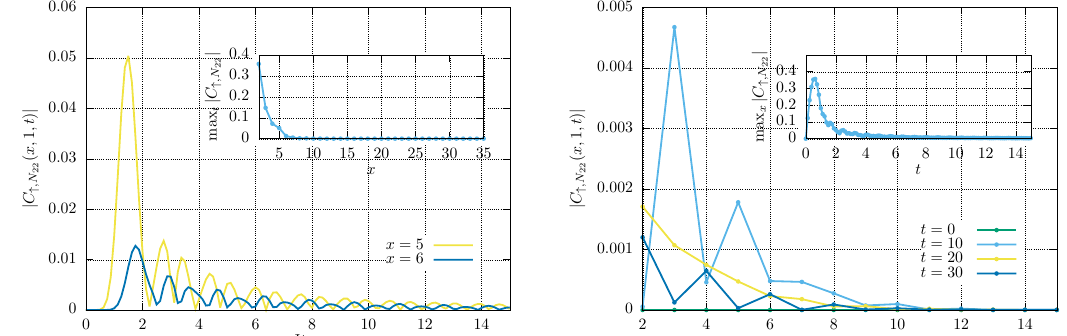
( x ,1, t ) after a quench Figure 4: Dynamics of the bulk boundary correlation C ↑ , N 22 from the nested Néel state (119) in the thermodynamic limit. The left panel reports ( x ,1, t ) | at two specific positions while the right panel the time evolution of | C ↑ , N 22 ( x ,1, t ) | (the insets respectively show the decay shows four fixed-time cuts of | C ↑ , N 22 | C ( x ,1, t ) | and in t of max | C ( x ,1, t ) | in x of max ↑ , N ↑ , N t x 22 22